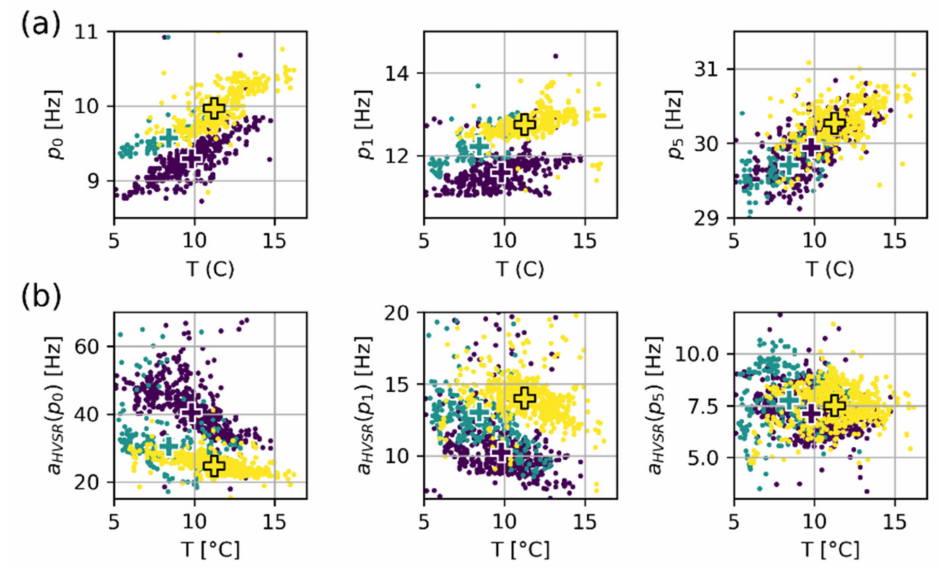
Figure 11. HVSR peak frequencies p n ( a ) and corresponding peak amplitudes a HVSR ( p n ) ( b ) as a function of air temperature. Initial stage before bolting is shown with dark blue dots. Stage between i 1 and i 2 is shown in green. Final stage after i 2 is shown with yellow dots. Centroid of each phase is pointed with a colored cross. Days with drilling works have been removed from the